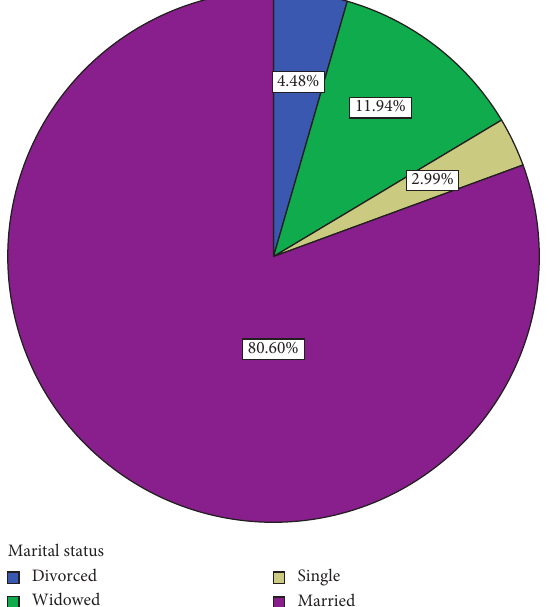
Figure 5: Distribution of number of hours participants worked.